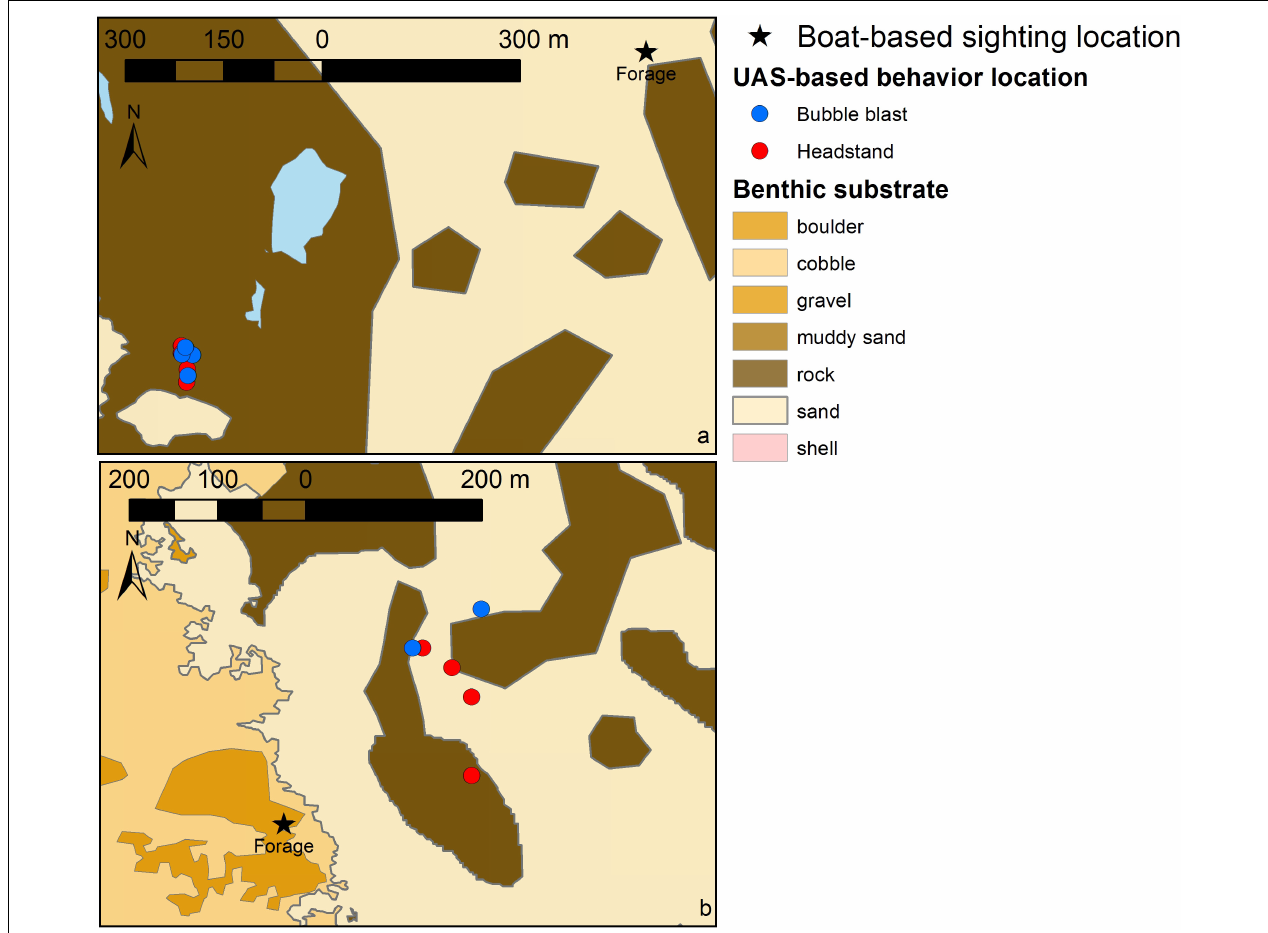
FIGURE 5 | Two examples of the boat-based location of a gray whale sighting (black star; labeled by recorded behavior state) and the UAS-based locations of sub-behavior events (see Table 1 for descriptions) recorded at these sightings (blue and red circles). (a) June 22, 2016 near Newport, OR, United States; blue areas indicate unclassified benthic substrate; (b) August 28, 2016 near Port Orford, OR, United States. Benthic substrate layer collected by multibeam in 2010 and provided by C. Goldfinger and C. Romsos, Active Tectonics and Seafloor Mapping Lab, Oregon State